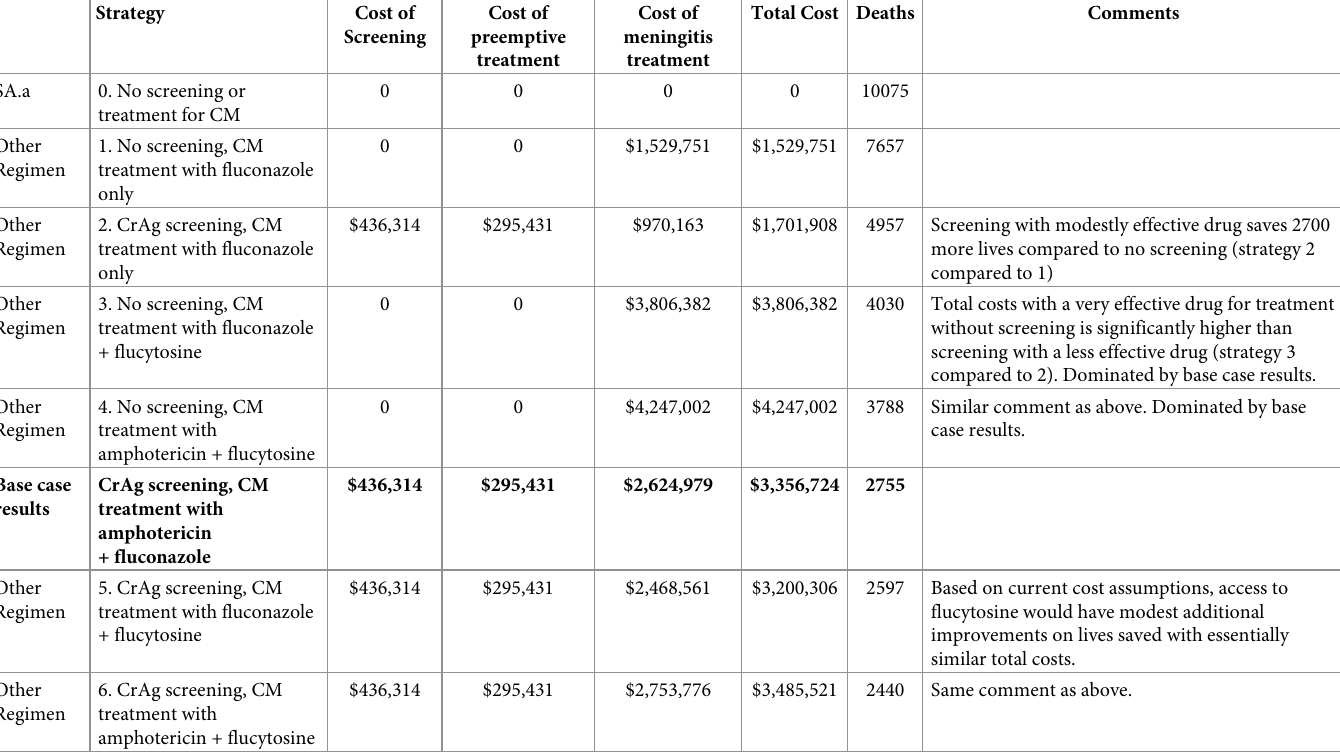
Table 6. Sensitivity of results to alternative meningitis treatment